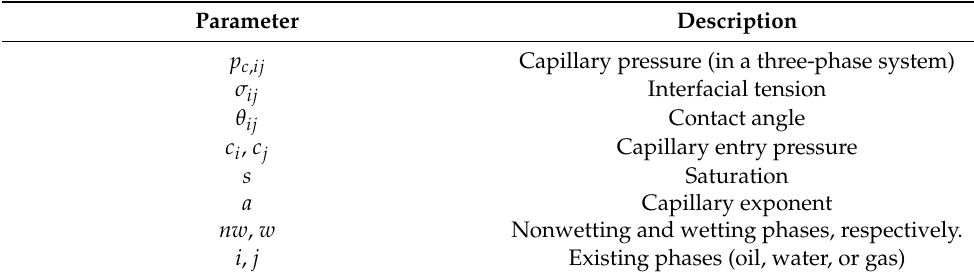
Table A1. Description of parameters used in Equation (A1)